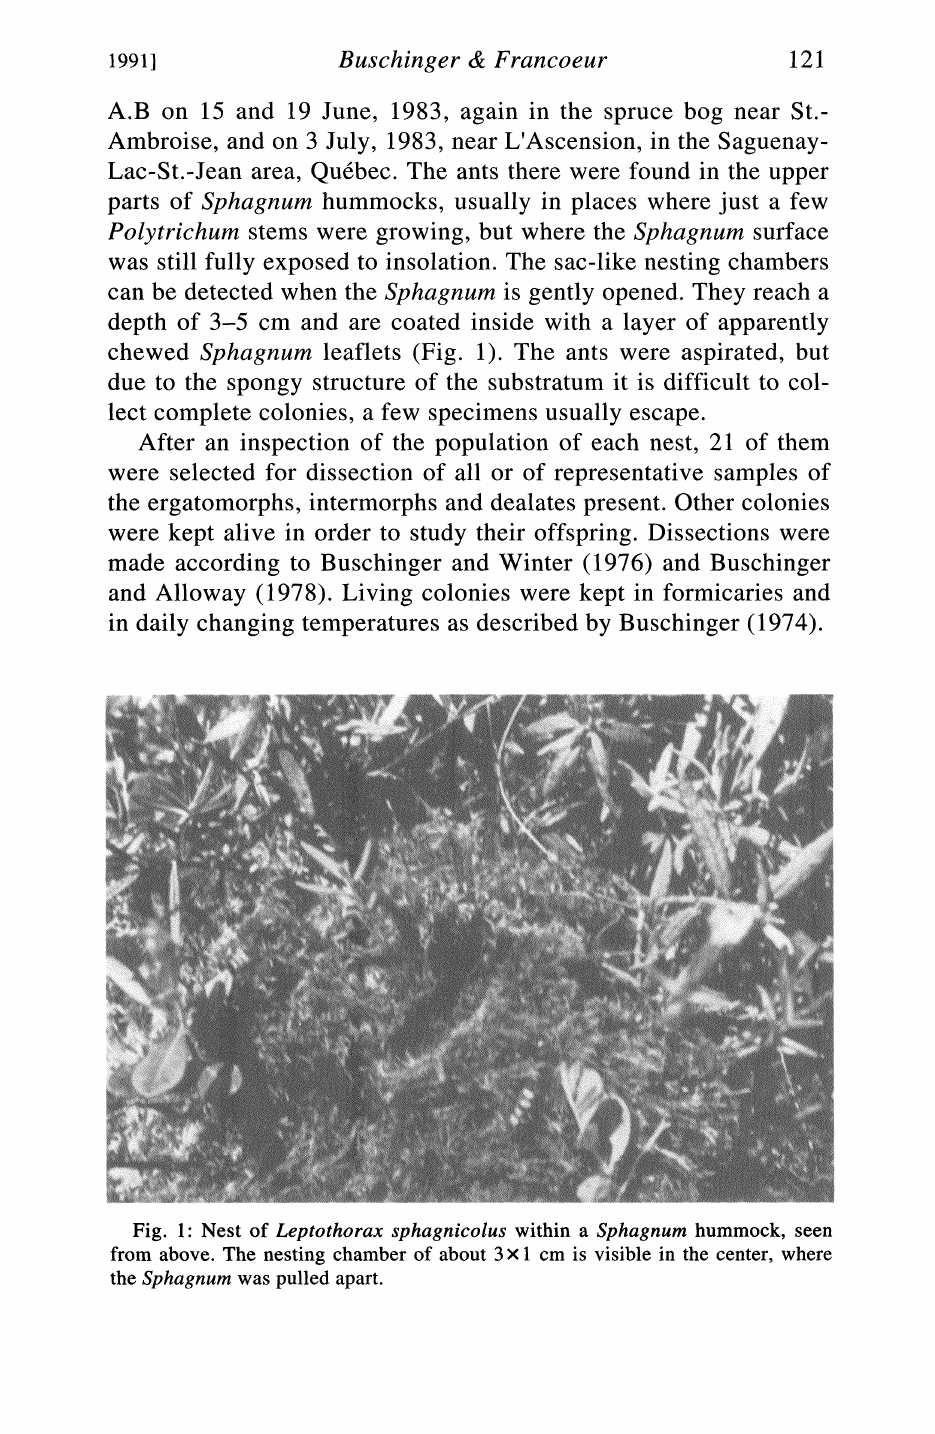
Fig. 1: Nest of Leptothorax sphagnicolus within a Sphagnum hummock, seen from above. The nesting chamber of about 3 cm is visible in the center, where the Sphagnum was pulled